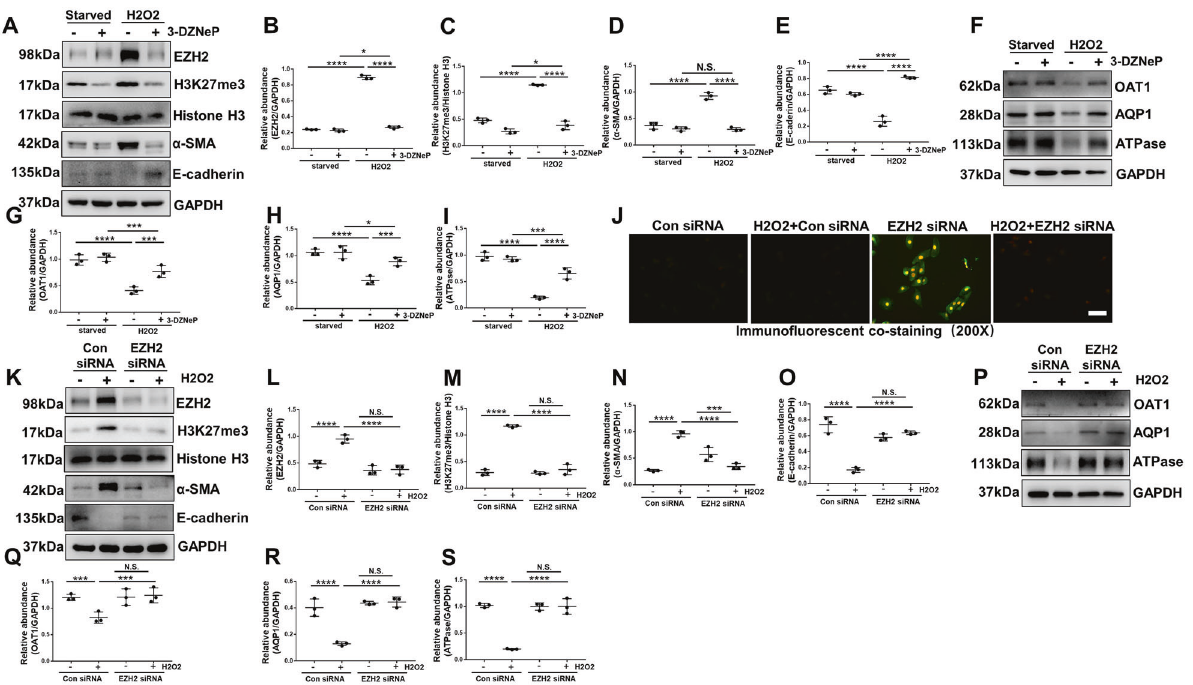
Fig. 5 Genetic or pharmacological depletion of EZH2 inhibits H 2 O 2 induced partial EMT of cultured human tubular epithelial cells. Starved HK2 cells were exposed to H 2 O 2 (0.5 mM) in the presence of 3-DZNeP (5 μ M) for 24 h before cell harvesting. A Cell lysates treated with 3-DZNeP were subjected to immunoblotting analysis with antibodies against EZH2, H3K27me3, Histone H3, α -SMA, E-cadherin, and GAPDH. B – E Expression levels of EZH2, H3K27me3, α -SMA, E-cadherin were quanti fi ed by densitometry and normalized with GAPDH and Histone H3. F Cell lysates treated with 3-DZNeP were subjected to immunoblotting analysis with antibodies against OAT1, AQP1, ATPase, and GAPDH. G – I Expression levels of OAT1, AQP1, ATPase were quanti fi ed by densitometry and normalized with GAPDH. J Photomicrographs showed the immuno fl uorescent co-staining of EZH2 and α -SMA in the HK2 cells of each group. HK2 cells were transfected with EZH2 siRNA and scrambled siRNA for 6 h, and then incubated with or without H 2 O 2 (0.5 mM) for an additional 24 h before being harvested for analysis. K Cell lysates transfected with EZH2 siRNA were subjected to immunoblotting analysis with antibodies against EZH2, H3K27me3, Histone H3, α -SMA, E- cadherin, and GAPDH. L – O Expression levels of EZH2, H3K27me3, α -SMA, E-cadherin were quanti fi ed by densitometry and normalized with GAPDH and Histone H3. P Cell lysates transfected with EZH2 siRNA were subjected to immunoblotting analysis with antibodies against OAT1, AQP1, ATPase, and GAPDH. Q – S Expression levels of OAT1, AQP1, ATPase were quanti fi ed by densitometry and normalized with GAPDH. Data were expressed as means ± SEM. * P < 0.05; ** P < 0.01; *** P < 0.001; **** P < 0.0001. N.S., statistically not signi fi cant, with the comparisons labeled. All scale bars = 50 μ